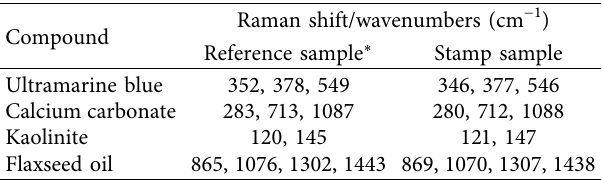
Figure 11: The reflections of the Raman spectroscopy for the blue printing ink in the stamp (a) and red printing ink in the stamp (b). Table 2: Raman spectra of the blue stamp components.